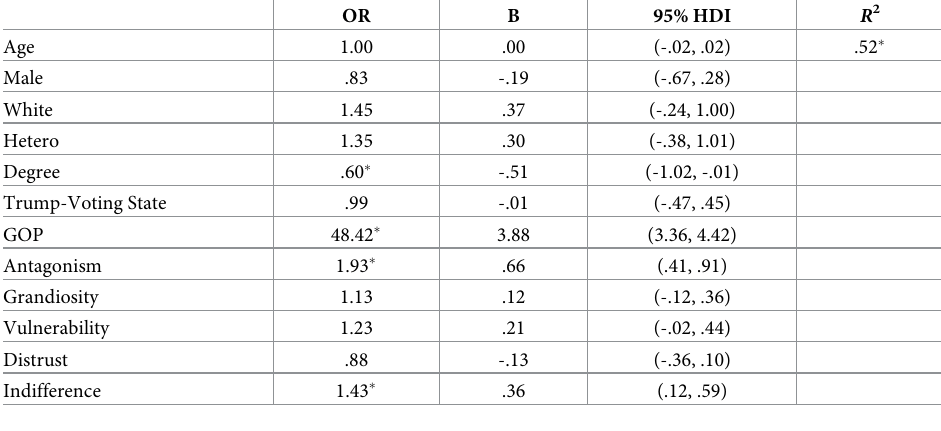
Table 2. Incremental effects of dimensions pathological narcissism on voting for Donald Trump in